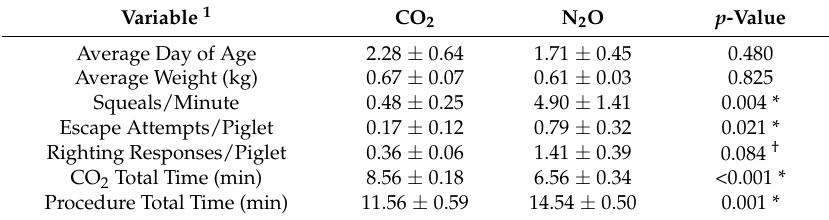
Table 5. Event and miscellaneous data (mean ± SE) collected on groups of piglets during Experiment 2.